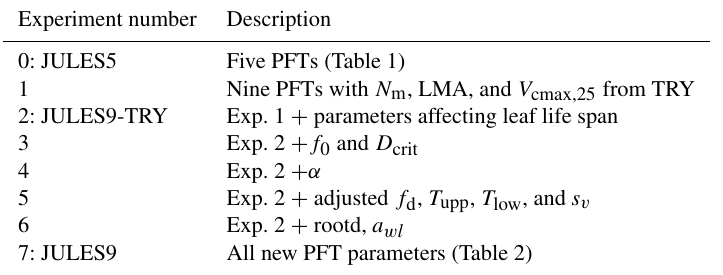
Table 3. Experiments for the FLUXNET site-level